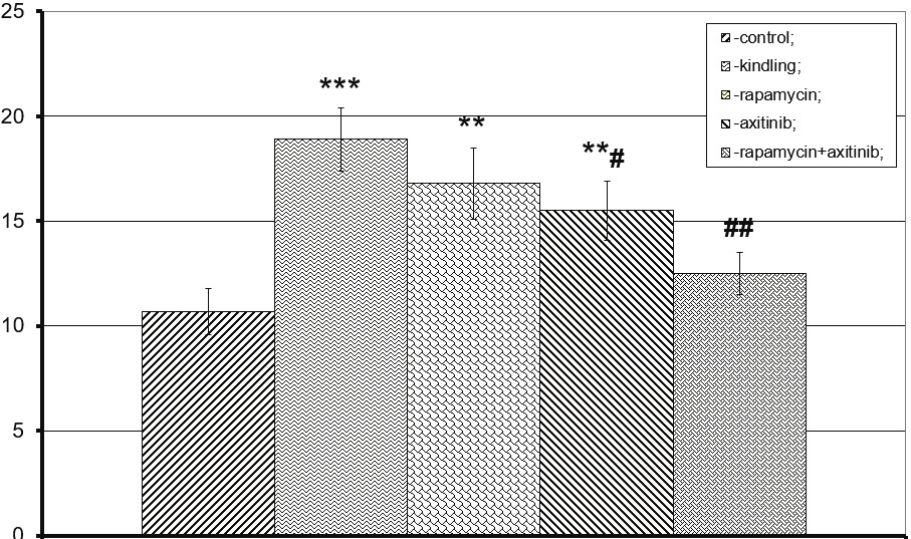
Fig. 5. Effects of treatment with rapamycin and axitinib upon HIF-1α expression in the hippocampus of kindled rats